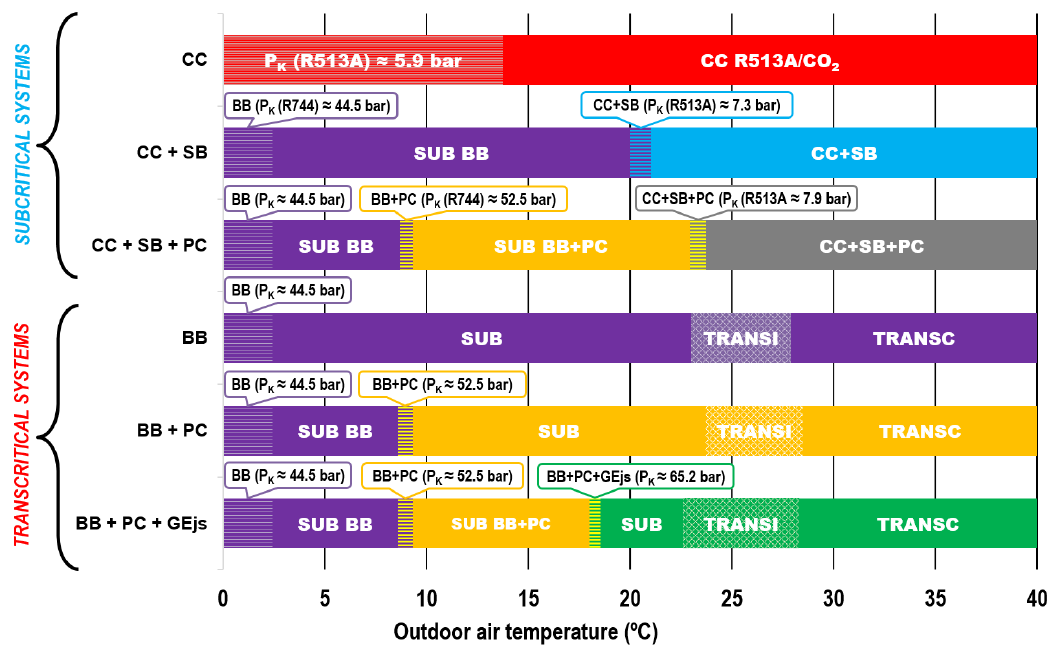
Figure 8. Operation of each architecture at different environmental temperatures.